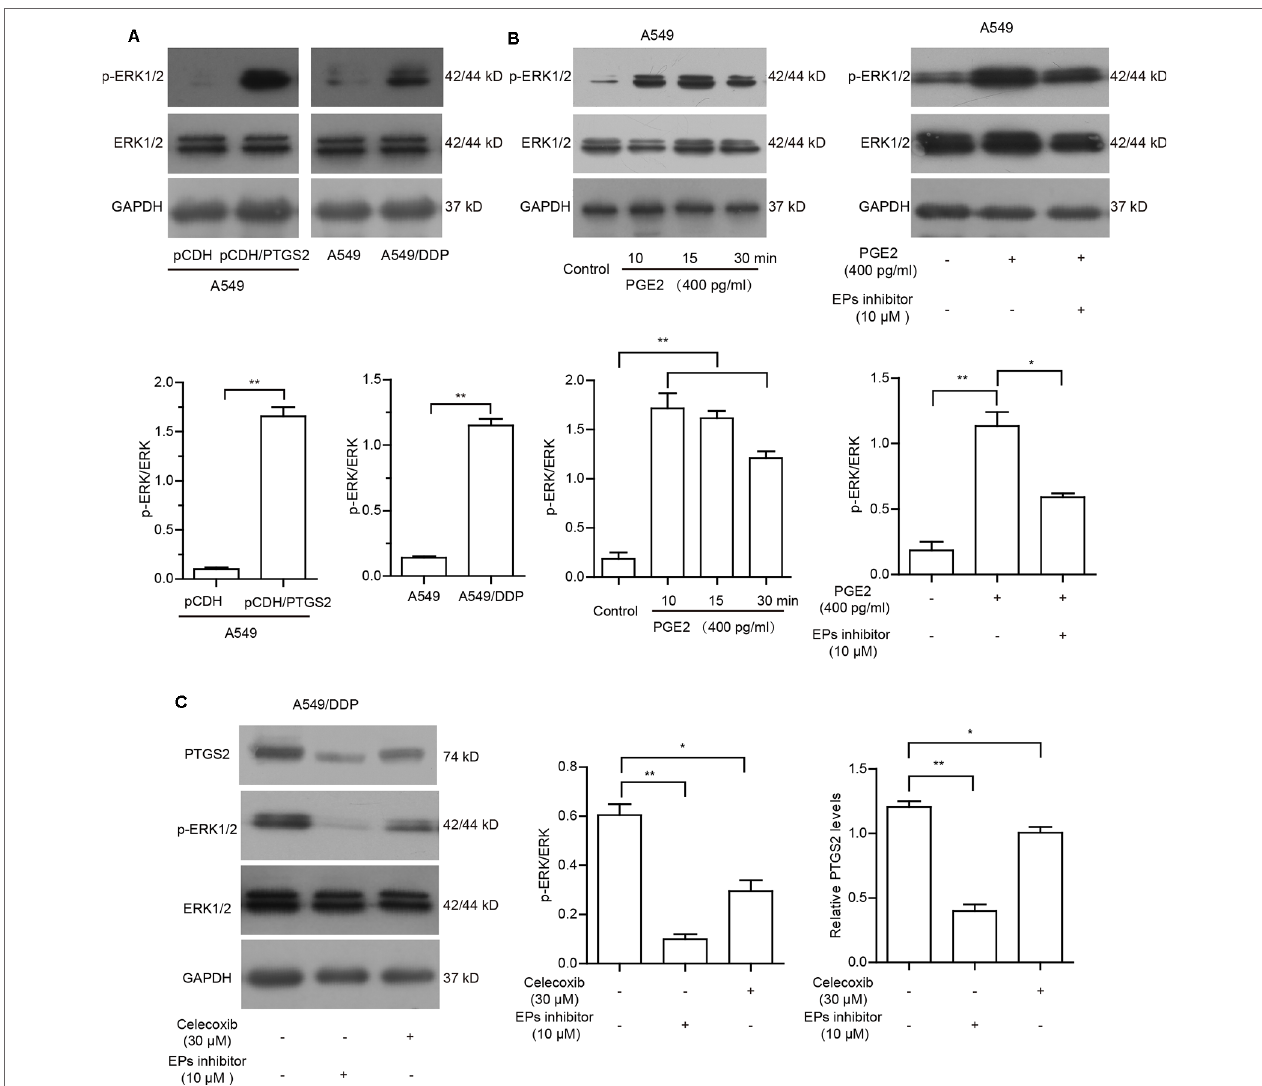
FIGURE 5 | PGE2 strengthened PTGS2 expression through the PGE2-EPs-ERK1/2 positive feedback loop. (A) A549-pCDH and A549-pCDH/PTGS2 cells (2.5 × 10 6 ), or A549 and A549 / DDP cells (3 × 10 6 ) were lysed to obtain protein samples for Western blot analysis of ERK1/2 activation. (B) A549 cells were treated with 400 pg/ml PGE2 for 10, 15, and 30 min, or treated with 10 μM EPs inhibitor for 1 h before addition of 400 pg/ml PGE2, followed by Western blot analysis of ERK1/2 activation. (C) A549/DDP cells were treated with 30 μM celecoxib or 10 μM EPs inhibitor prior to Western blot analysis of PTGS2 expression and ERK1/2